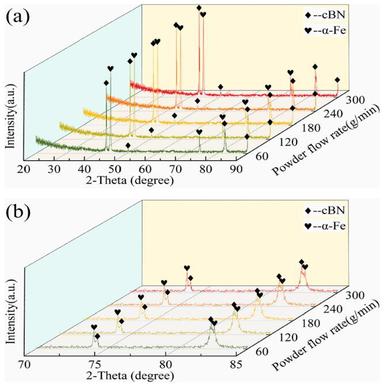
XRD phase identification with different powder flow rates: (a)20–90◦; (b)70–85◦.